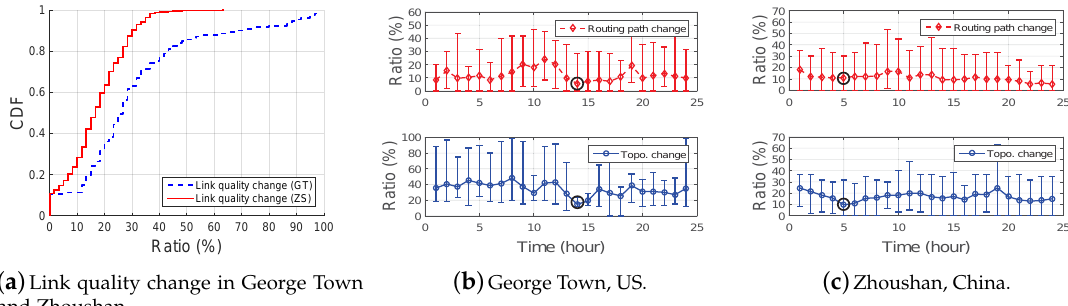
Figure 2. Investigation of the data property in the two systems in George Town (GT) and Zhoushan (ZS): ( a – c ) reveal the dynamics of systems, i.e., link quality, routing path, and topology change in 24 h,